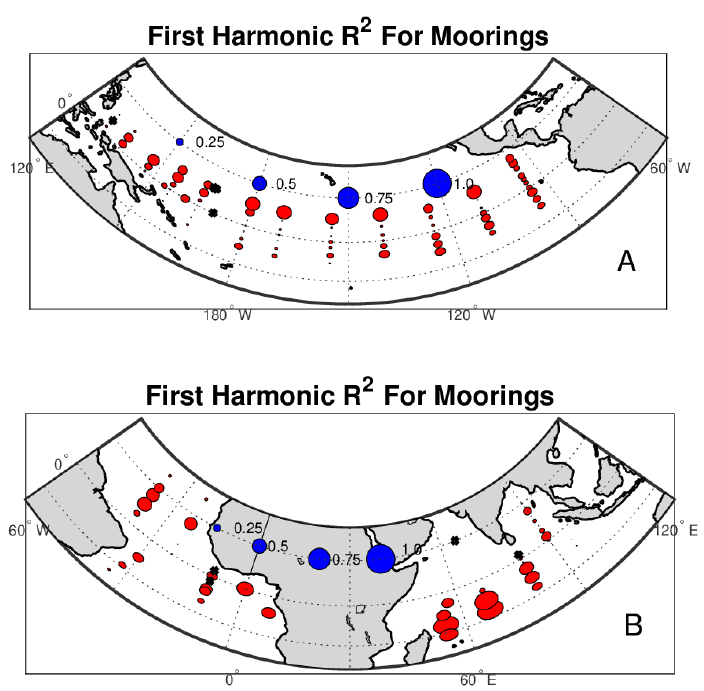
Figure 4. As in Figure 3, but for fraction of variance (R 2 ) explained by the annual harmonic fit. For completeness, we include maps of R 2 for all products for both annual (Table S2) and semiannual (Table S5) harmonics. (a) Pacific basin. (b) Atlantic and Indian basins.